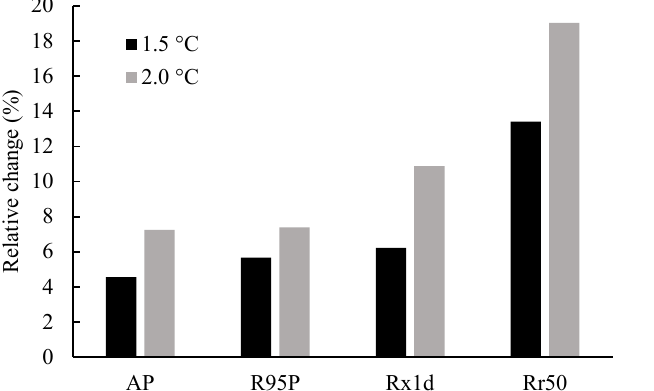
Figure 8. Relative changes in extreme rainfall indices under 1.5 ◦ C and 2.0 ◦ C global warming relative to baseline.